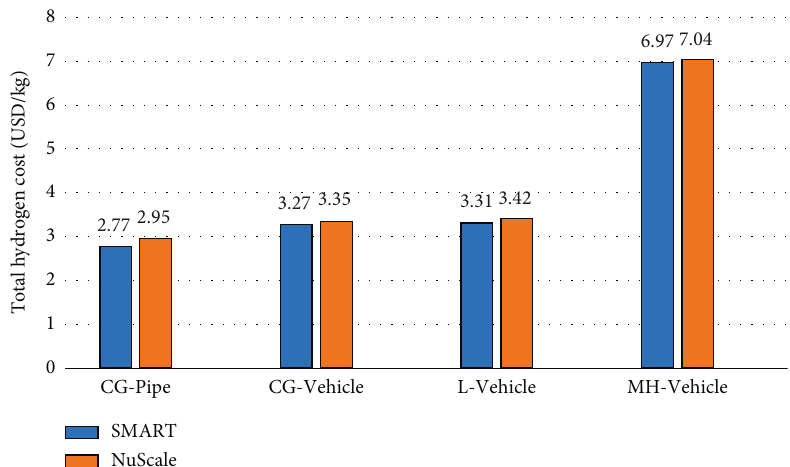
Figure 2: Comparison of hydrogen production cost using SMART and NPM.